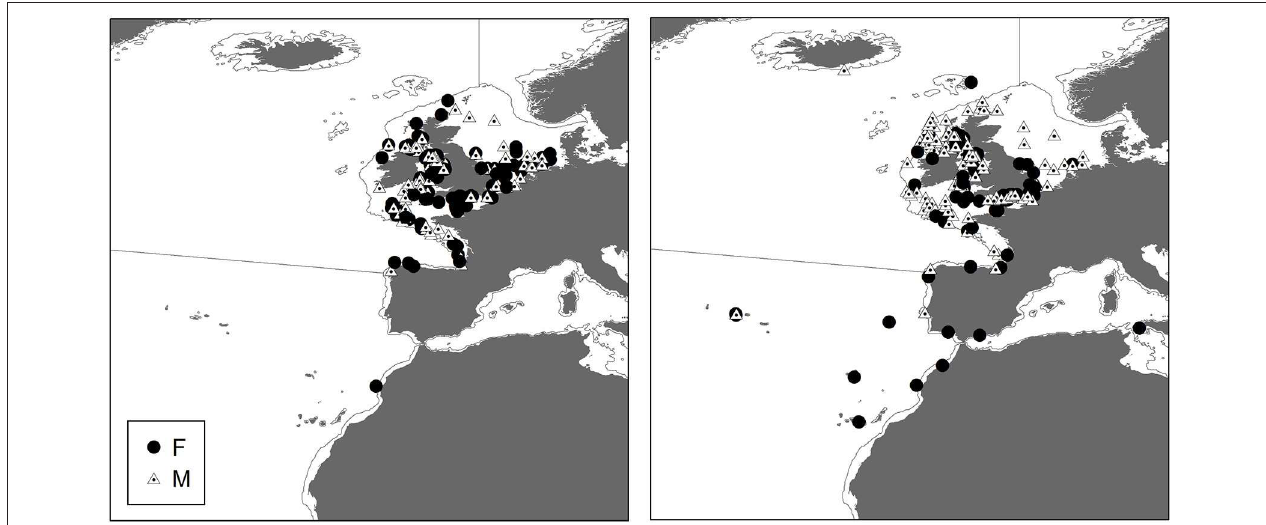
FIGURE 1 | Distribution of immature and mature tope with gender symbolized from presence data, combining mark-recapture, and International Bottom Trawl Survey (IBTS) data. (Left) Distribution of immature tope (m < 126cm, f < 130cm). (Right) Distribution of mature tope (m ≥ 126cm, f ≥ 130cm).